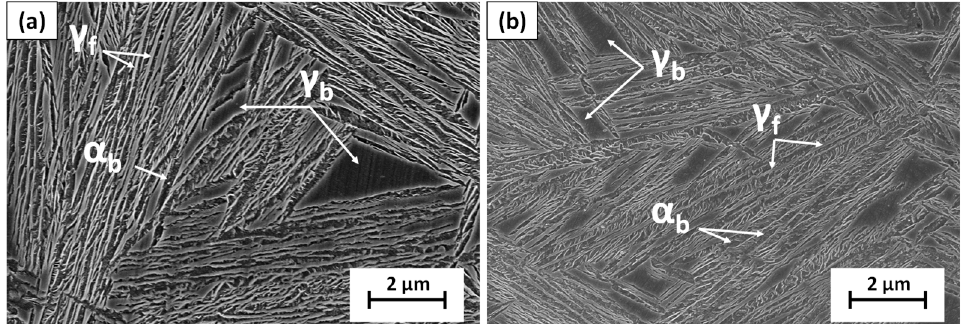
Figure 2. SEM micrographs of bainitic microstructures obtained after isothermal transformation at 250 ◦ C for 20 h in ( a ) 06CV and ( b ) 06C1MoV steels, where α b stands for bainitic ferrite and γ stands for retained austenite with film (f) and block (b) morphology.